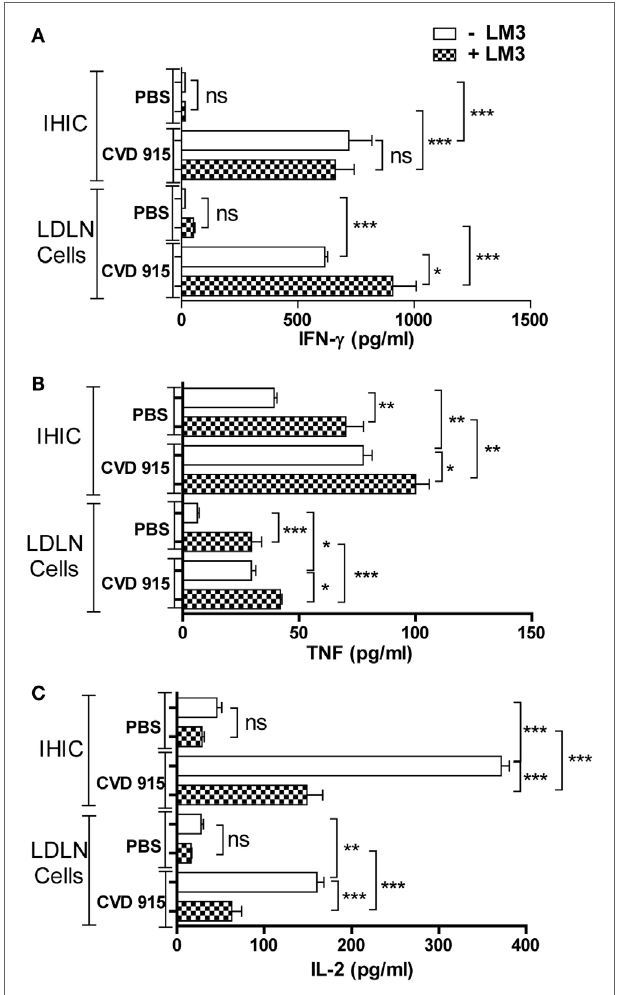
FigUre 4 | antitumor Th1-type cytokine production in the liver and liver-draining lymph nodes (lDln) from Salmonella -treated mice . Twenty-one days after treatment with CVD 915 or PBS, livers and LDLN from tumor-bearing mice were removed. Cytokine production was measured by ELISA in 96 h culture supernatants of intrahepatic immune cells (IHIC) and LDLN cells following exposure to LM3 tumor or not. (a) IFN- γ , (B) TNF, and (c) IL-2. The limits of detection were 30, 4, and 4 pg/ml, respectively. Samples from four to five animals per group were pooled. Data shown are mean values of triplicate or quadruplicate cultures and are representative of two independent experiments. ns, not statistically significant, * p < 0.05, ** p < 0.001, *** p <